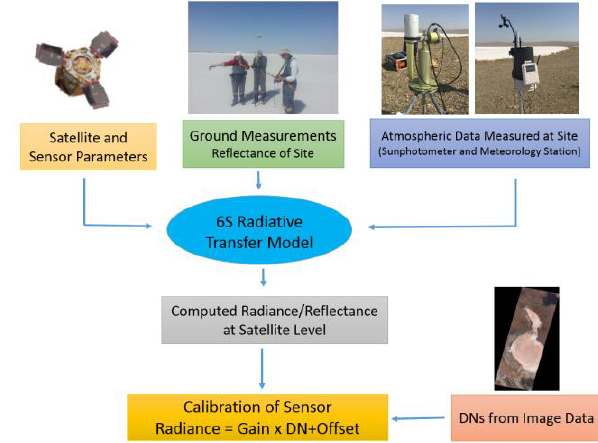
Figure 3. System architecture of the ground-based absolute